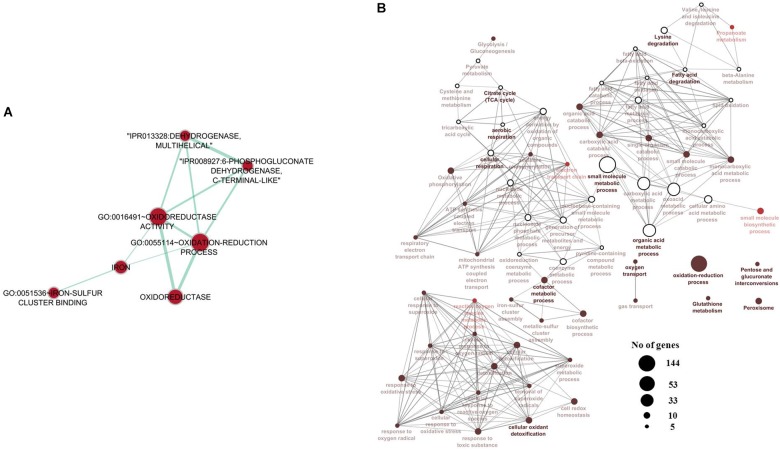
(A) Pathway clustering analysis performed on the 5327 genes exclusively affected by population. (B) Enriched functions and pathways of the metabolism-related genes exclusively related to population. The network of pathways was created with ClueGo and CluePedia Cytoscape apps. The pathways were functionally grouped and interconnected based on the kappa score. The size of the nodes indicates the number of genes associated. Pathways are colored based on their significance after Bonferroni correction, where the most significant terms are shown in dark red and the least significant terms are illustrated in white.